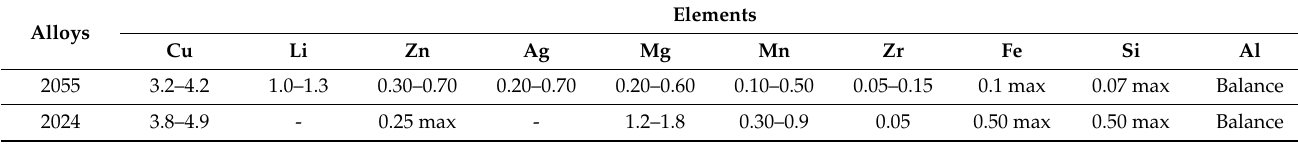
Table 1. The nominal chemical composition of aluminum alloys